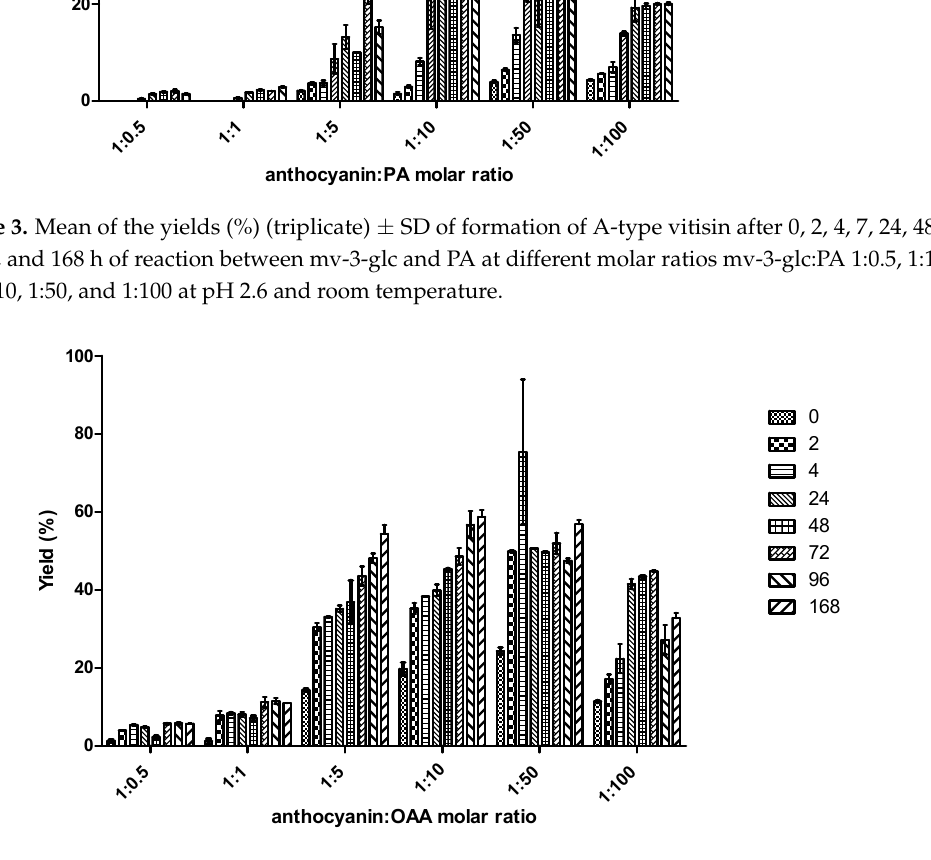
Figure 4. Mean of the yields (%) (triplicate) ± SD of formation of A-type vitisin after 0, 2, 4, 24, 48, 72, 96, and 168 h of reaction between mv-3-glc and OAA at different molar ratios mv-3-glc:OAA 1:0.5, 1:1, 1:5, 1:10, 1:50, and 1:100 at pH 2.6 and room temperature.